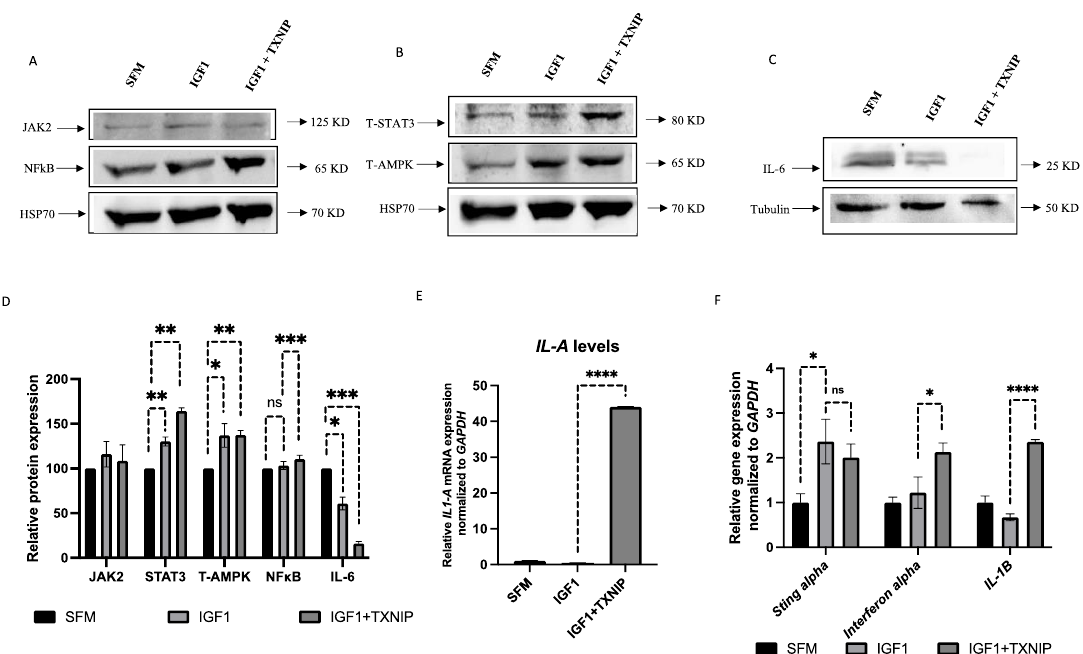
Figure 8. Effect of TXNIP on STAT3/IL-1A-mediated SASP in IGF1-induced senescence . ( A – C ) Pri- mary skin fibroblasts were treated with IGF1 for 11 days (lane 2), transfected with a TXNIP-GFP vector during the last 24 h of IGF1 treatment (lane 3), or serum-starved for the entire period and transfected with an empty pcDNA-GFP plasmid (lane 1). Cells were then lysed and the levels of the indicated proteins were measured by Western blots. ( D ) Scanning densitometry analysis of JAK2, STAT3, NFkB, T-AMPK and IL-6 levels in IGF1-treated and IGF1-treated/TXNIP-transfected cells relative to serum-starved, empty vector-transfected cells. ( E ) RT-QPCR analysis of IL-1A mRNA levels in control, IGF1-treated and IGF1/TXNIP-treated fibroblasts. ( F ) RT-QPCR analysis of STING-alpha , interferon-alpha and IL-1B mRNA levels in control, IGF1-treated and IGF1/TXNIP-treated fi- broblasts. * p - value ≤ 0.05; ** p - value ≤ 0.01; *** p - value ≤ 0.001; **** p - value ≤ 0.0001.